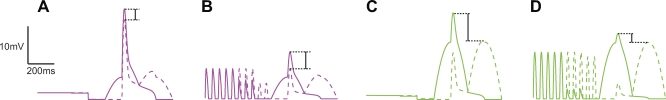
Response, V
∞(t), of the Two State Model to a Pulse Stimulus(A,C) Initialized with a temporally and spatially uniform 50% grey stimulus.(B,D) Initialized with global synchronous gamma-band oscillations. Solid lines represent responses to movement in the preferred direction, dashed lines to the non-preferred direction. The responses in each plot are aligned to the peak of the PSP from the depressing synapse. This facilitates the comparison between the preferred and non-preferred directions of movement, but as a result, the onsets of the moving stimuli are not aligned. In the preferred direction, the object passes first through the nondepressing part of the receptive field and then enters the depressing part. Parameters of the model for this and all remaining figures are the same as listed in Figure 2 except for the synaptic factors, which vary. For A and B (magenta): gn = 0.2, gd = 8. For C and D (green): gn = 0.6, gd = 4. The stimulus parameters used throughout for the pulse stimulus are fg = 20 Hz, A
g = 0.7, or A
g = 0 (respectively, with or without initializing global synchronous oscillations), t
0 = −1,000 msec, ts = 0 msec, tf = 5,500 msec, ϕ = 135°; σ, p
0, and p
1 differed depending on direction of movement: σ = 1, p
0 = −16p, p
1 = −19p, (preferred direction); σ = −1, p
0 = −15p, p
1 = −19p (non-preferred direction).